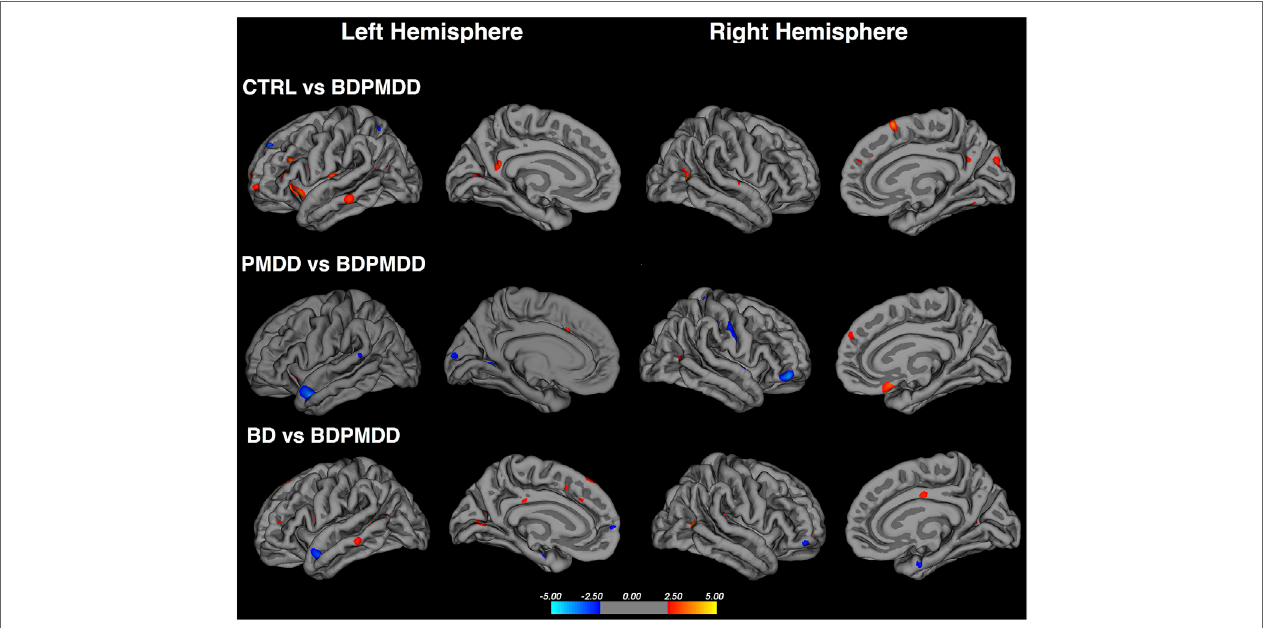
FigUre 2 | Cortical thickness across groups compared to BD with comorbid PMDD (BDPMDD). Regional differences in cortical thickness are shown with reference to the first group in the comparison. Blue regions represent decreased cortical thickness; Red regions represent increased cortical thickness. Further details are shown in Table 5